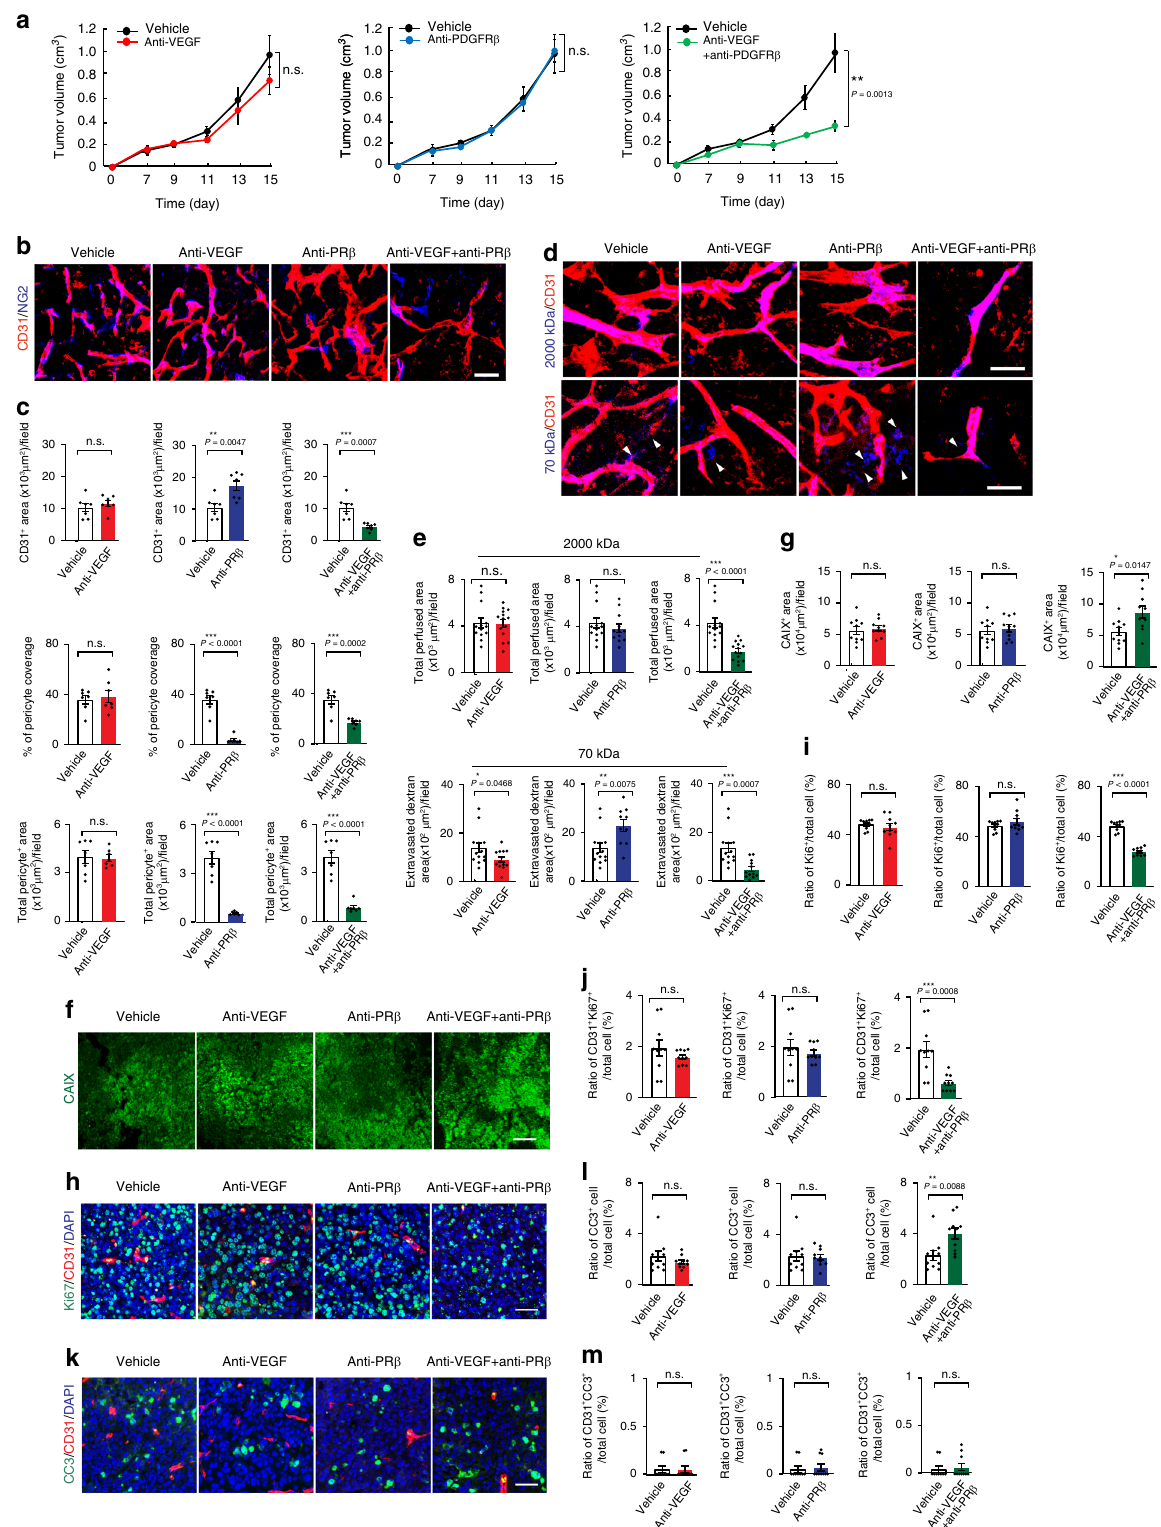
signi fi cantly decreased in thyroid, but not decreased in kidney and skeletal muscles (Supplementary Fig. 9). Pericyte coverage and leakiness of 70-kDa fl uorescein-lysinated dextran were not altered. These fi ndings are consistent with previous reports that endocrine vasculatures are highly sensitive to systemic anti-VEGF therapy.